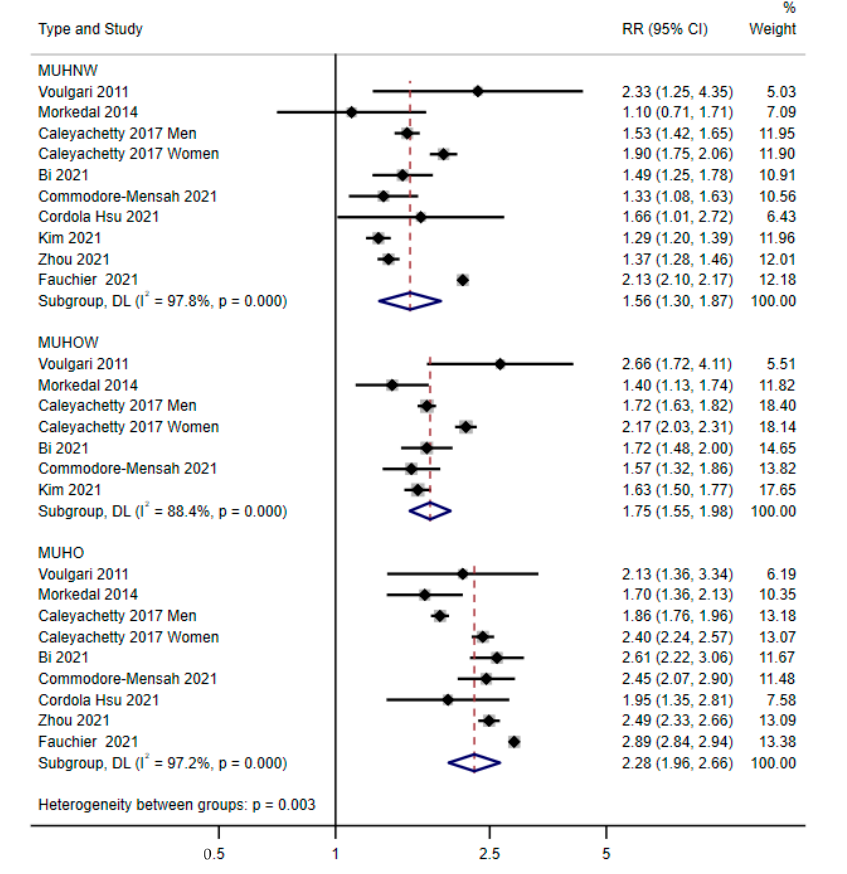
Figure 3. Pooled results of the comparison of the risk of heart failure associated with metabolically unhealthy normal weight, overweight, or obesity, compared with that of the metabolically healthy normal-weight group [14–16,18–20,22,23,30,31]. MUHNW: Metabolically unhealthy normal-weight group, MUHOW: Metabolically unhealthy overweight group, MUHO: Metabolically unhealthy obesity group. Table 2. Subgroup analysis according to study